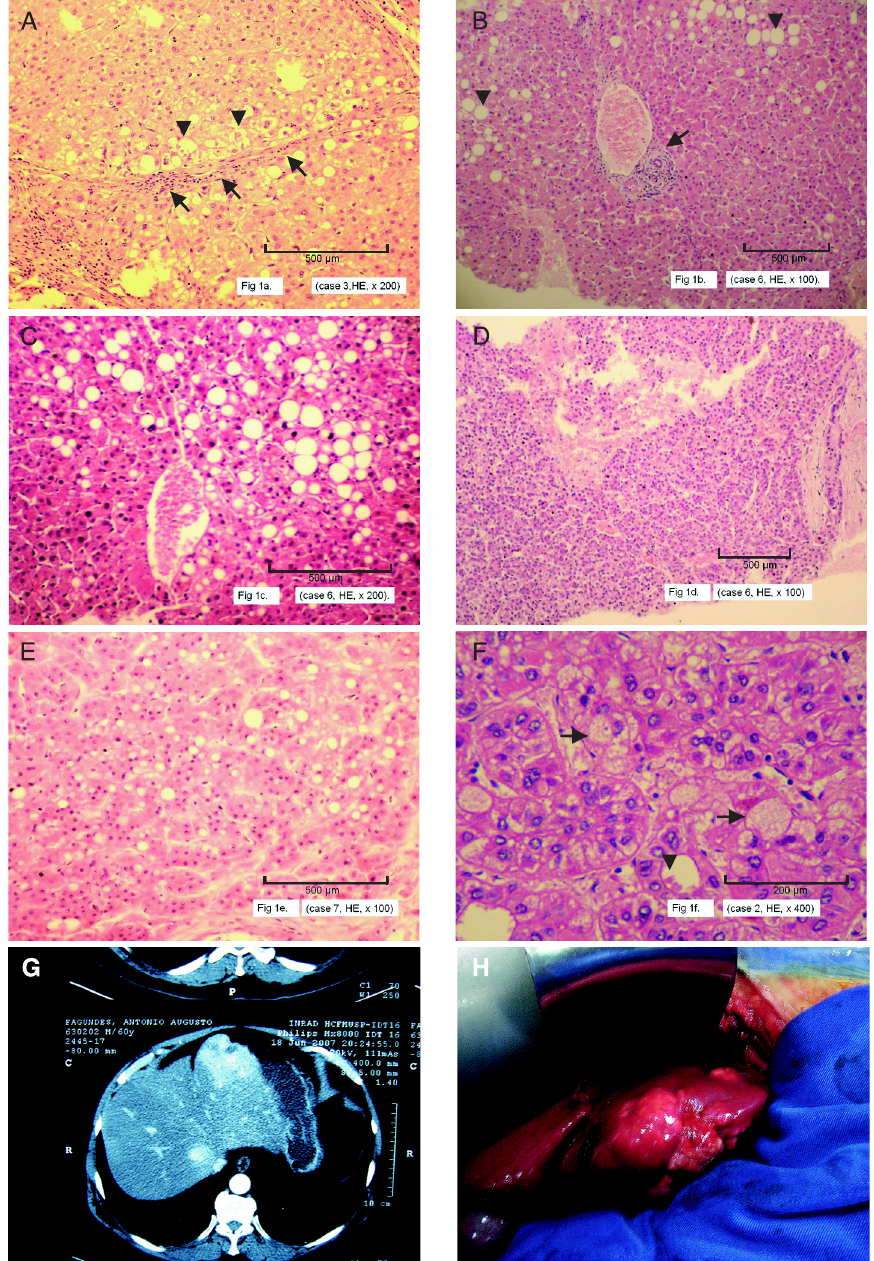
Figure 1. Microscopic features of non-neoplastic areas and of hepatocellular carcinoma (HCC). A , Hepatic cirrhosis with thin septae (arrows). Prominent hepatocellular ballooning (arrowheads) is seen together with Mallory bodies. Grade I steatosis and scarce polymor- phonuclear and lymphocytic inflammation (case 3, HE, 200X). B , Steatohepatitis stage 1 contralateral to HCC. An individualized portal tract shows minimal inflammation and no fibrosis (arrow). Steatosis is seen in 15-20% of hepatocytes (arrowheads, case 6, HE, 100X). C , Another microscopic field of the same case, presenting a preserved terminal (centrilobular) venule, surrounded by steatotic hepato- cytes. Some polymorphonuclears are found (case 6, HE, 200X). D , Well-differentiated HCC presenting small hepatocytes crowded in thin trabeculae in the non-alcoholic steatohepatitis (NASH) case without cirrhosis (case 6, HE, 100X). E , Well-differentiated HCC show- ing micro- and macrogoticular steatosis (case 7, HE, 100X). F , Moderately differentiated HCC presenting features of NASH: ballooning (arrows) and Mallory bodies (arrowhead) are found in neoplastic cells (case 2, HE, 400X). G , Computed tomographic scan indicating a steatotic liver with a hypervascular mass in segment 3. H , Intraoperative view of a non-cirrhotic liver with a tumor located in segment